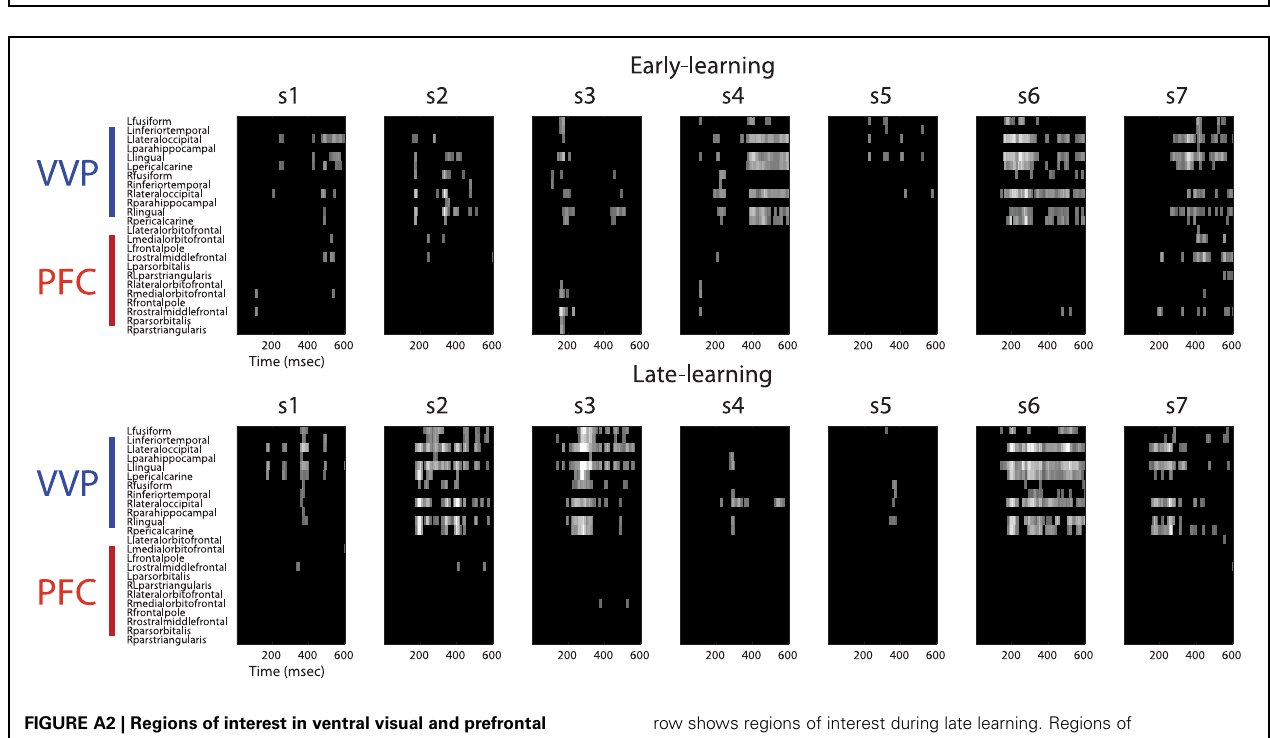
computed from trials with shuffled category labels (100 permutations). The 95% confidence intervals of the permuted time course (almost) overlap with the mean.